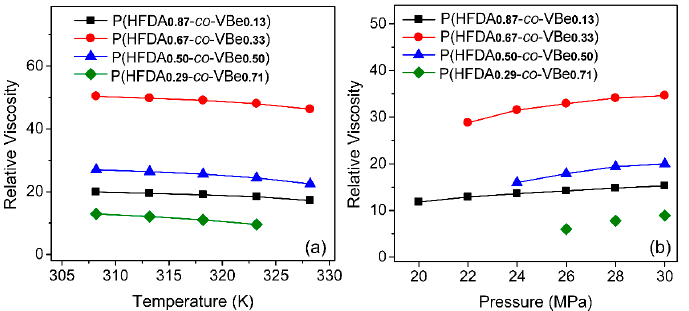
Figure 7. Relative viscosities of the co-polymer–CO 2 systems versus temperature ( a ) and pressure ( b ).